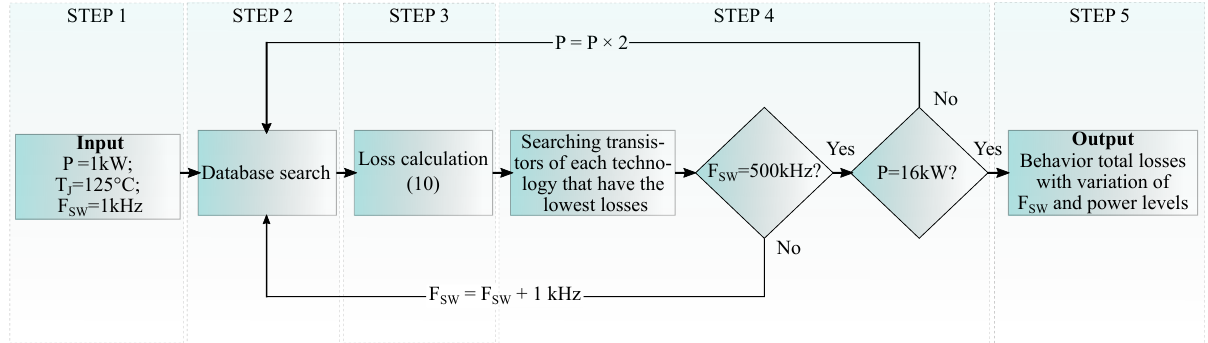
Figure 9. Flowchart: methodology for the selection of the MOSFET with lowest total losses for each